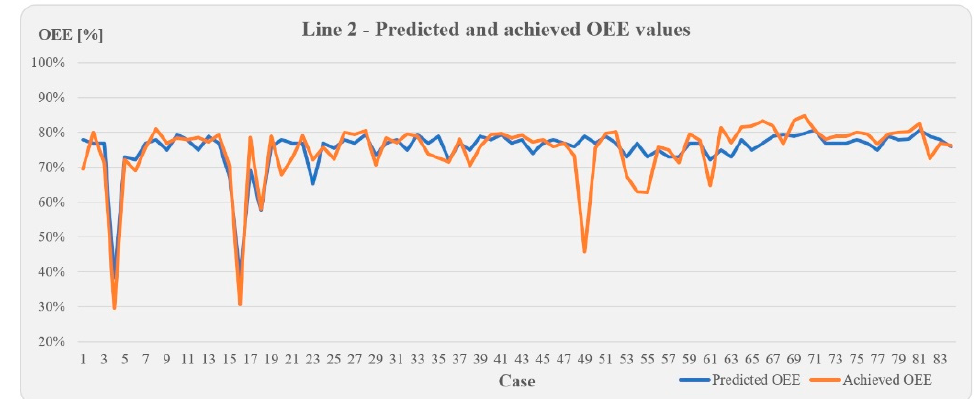
Figure 3. Predicted and achieved OEE values for assembly line 2. Table 4. Descriptive statistics OEE values for assembly line 1 and assembly line 2.